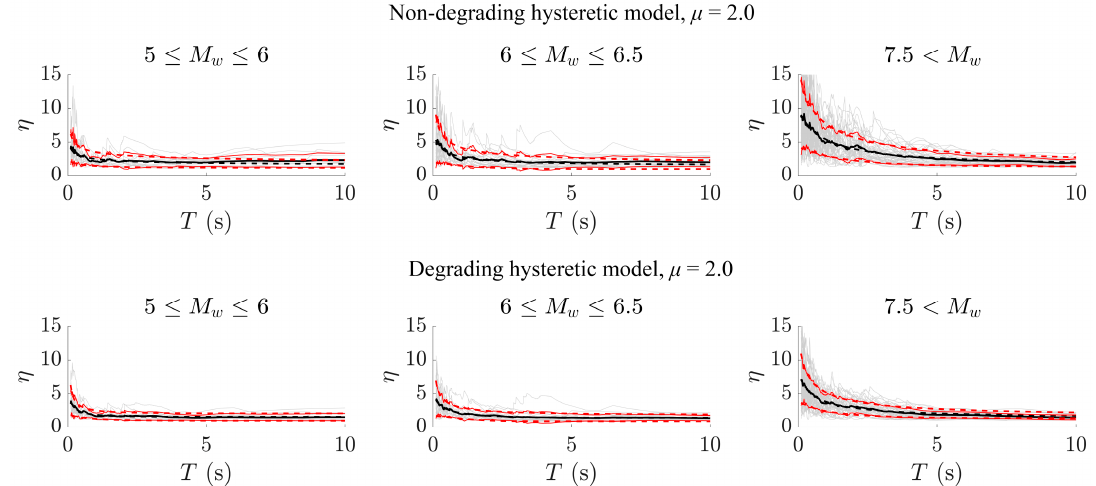
Figure 12. Comparison between calculated hysteretic energy reduction factor R Ha spectra (mean and mean plus/minus one standard deviation) and proposed approximation (thin solid line: single spectrum; thick solid line: calculated spectrum; thick dashed line: proposed approximation).